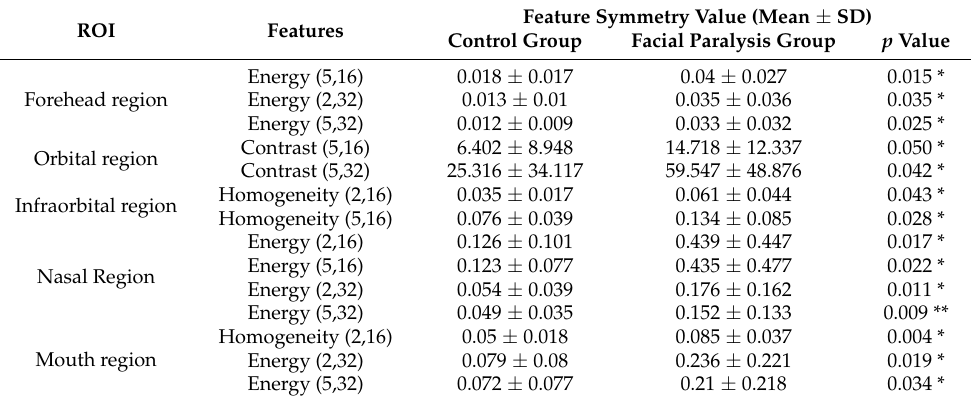
Table 6. Symmetry measurements of texture features using the Manhattan distance (the offset distance ∆ of the GLCM is set to 2 and 5, and the maximum gray level is set to 16 and 32). Feature Symmetry Value (Mean ± SD) ROI Features Control Group Facial Paralysis Group p Value Energy (5,16) Forehead region